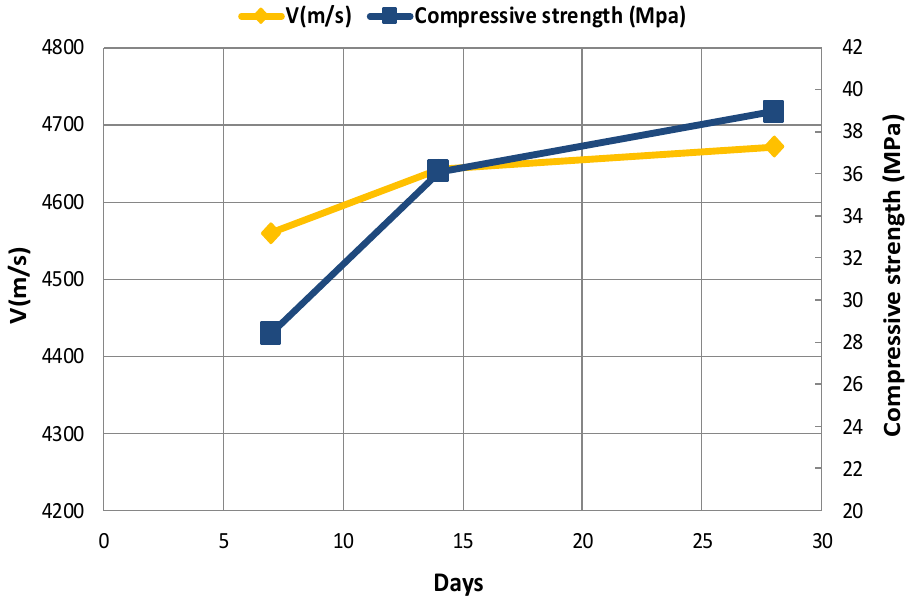
Figure 17. Comparison of UPV and compressive strength at 5% replacement of sand (S-J-S) .